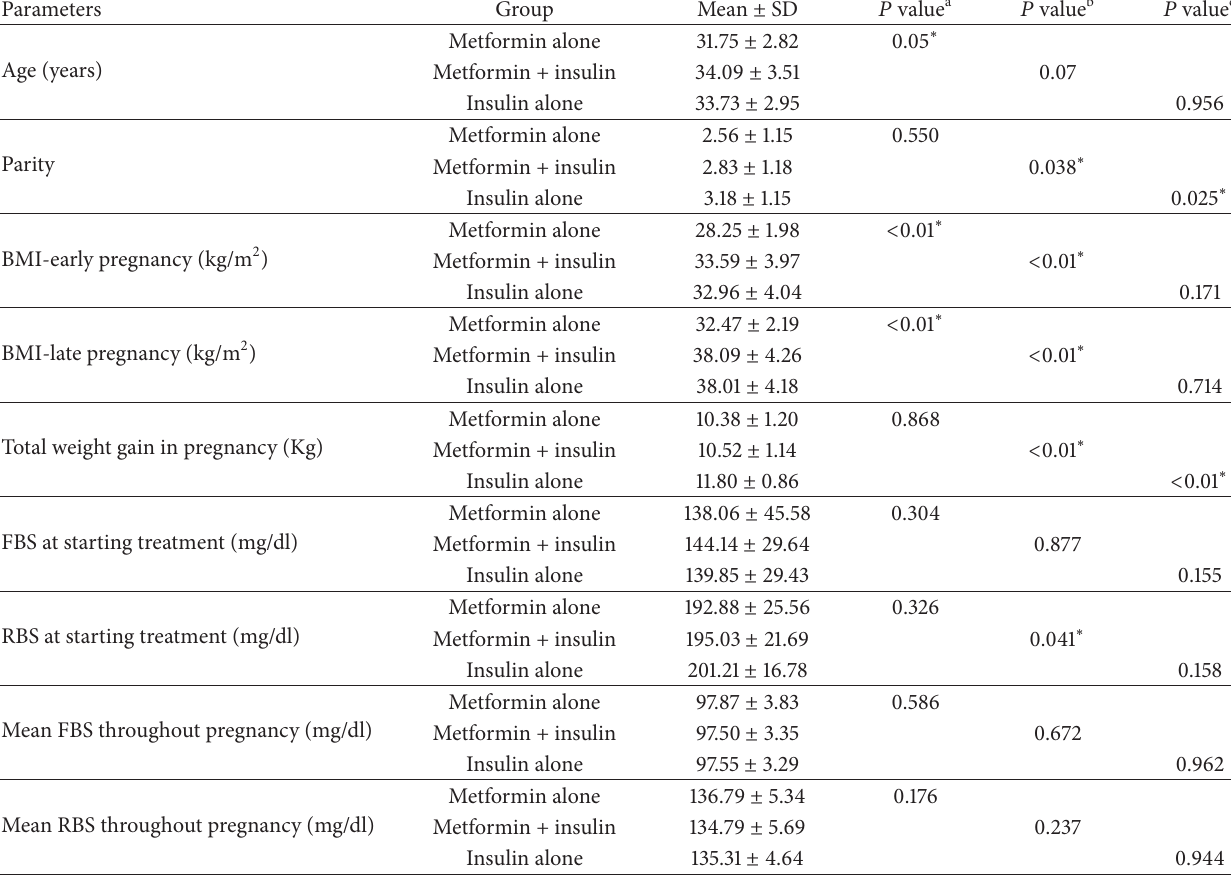
Table 1: Baseline demographic and maternal characteristics in treatment groups ( 𝑛 = 206